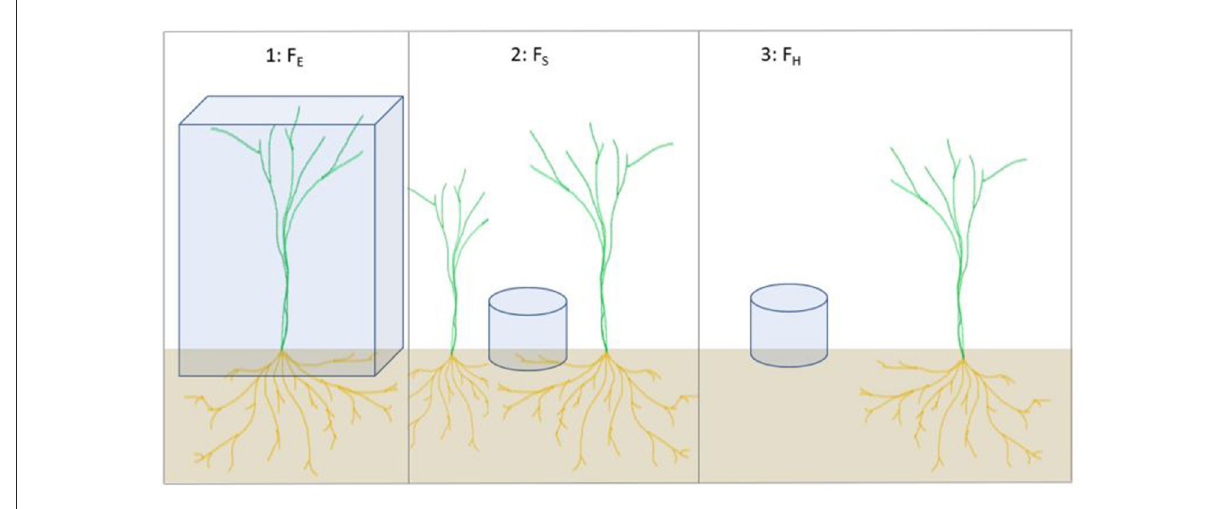
FIGURE3 Schematic illustration of the different fluxes measured using the darkened chamber technique with either small or large chambers: whole ecosystem (F E ), soil (F S ), and heterotrophic (F H ) fluxes. The F E chambers included 10 oat